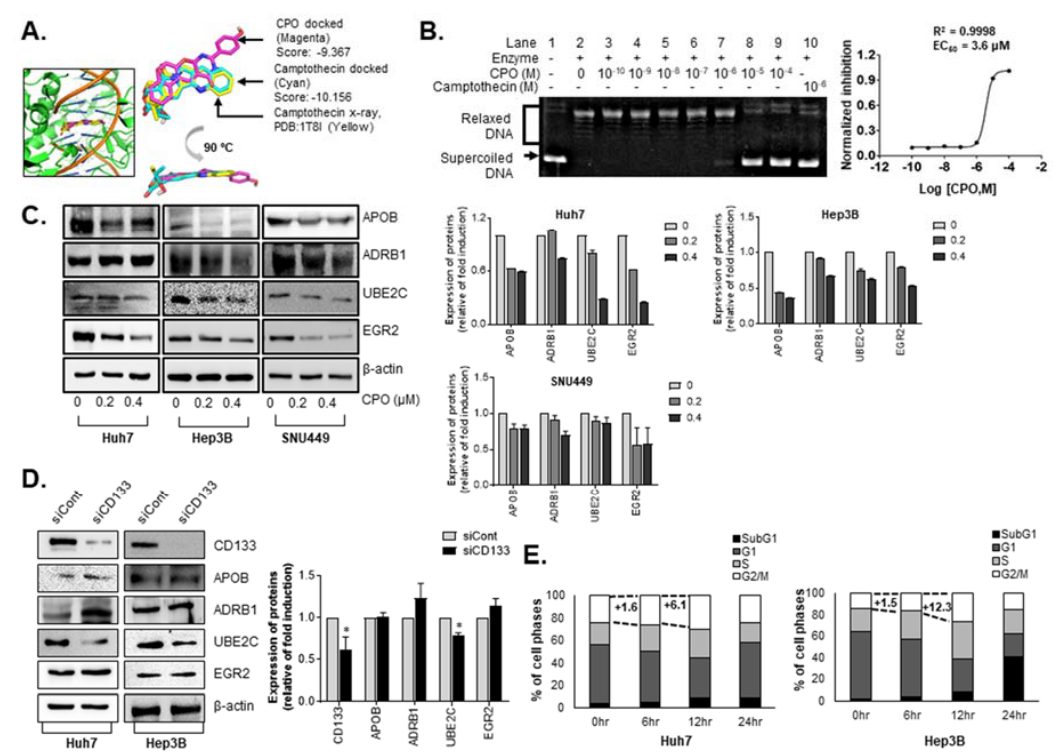
Figure 6. CPO inhibits expression of ADRB1, APOB, EGR2, and UBE2C in HCC. ( A ) Predicted binding mode of CPO (in magenta) located between the nicked DNA bases in topoisomerase I active site with a superimposition to x ‐ ray structure (in yellow) and docked pose (in cyan) of camptothecin. ( B ) Inhibition of human topoisomerase I activity by CPO evaluated using DNA relaxation assay in dose ‐ diluted manner. ( C ) RNA ‐ sequencing results of the expression of novel target proteins in Huh7, Hep3B, and SNU449 cells after treatment with 200 nM or 400 nM CPO for 48 h (left panel). Expression level of proteins was quantified (right panel). The whole blot image can be found in Figures S6, S7 and S8. ( D ) Expression of novel target protein in CD133 ‐ depelted HCC cell lines (Huh7 and Hep3B) (left panel). Expression of proteins in siCont and siCD133 was quantified (right panel). β‐ actin was used as the control (whole blot image, Figure S9). ( E ) Percentages of cell cycle phase (SubG1, G1, S, and G2/M) after treatment with 200 nM CPO for 6, 12, and 24 h determined by flow cytometry in Hep3B and Huh7 cells (left panel). Graph of percentages of cell phase was shown (right panel). The data shown are from three independent experiments relative to the control values and the mean values ± SD from three independent experiments; * p < 0.05 compared to control group.